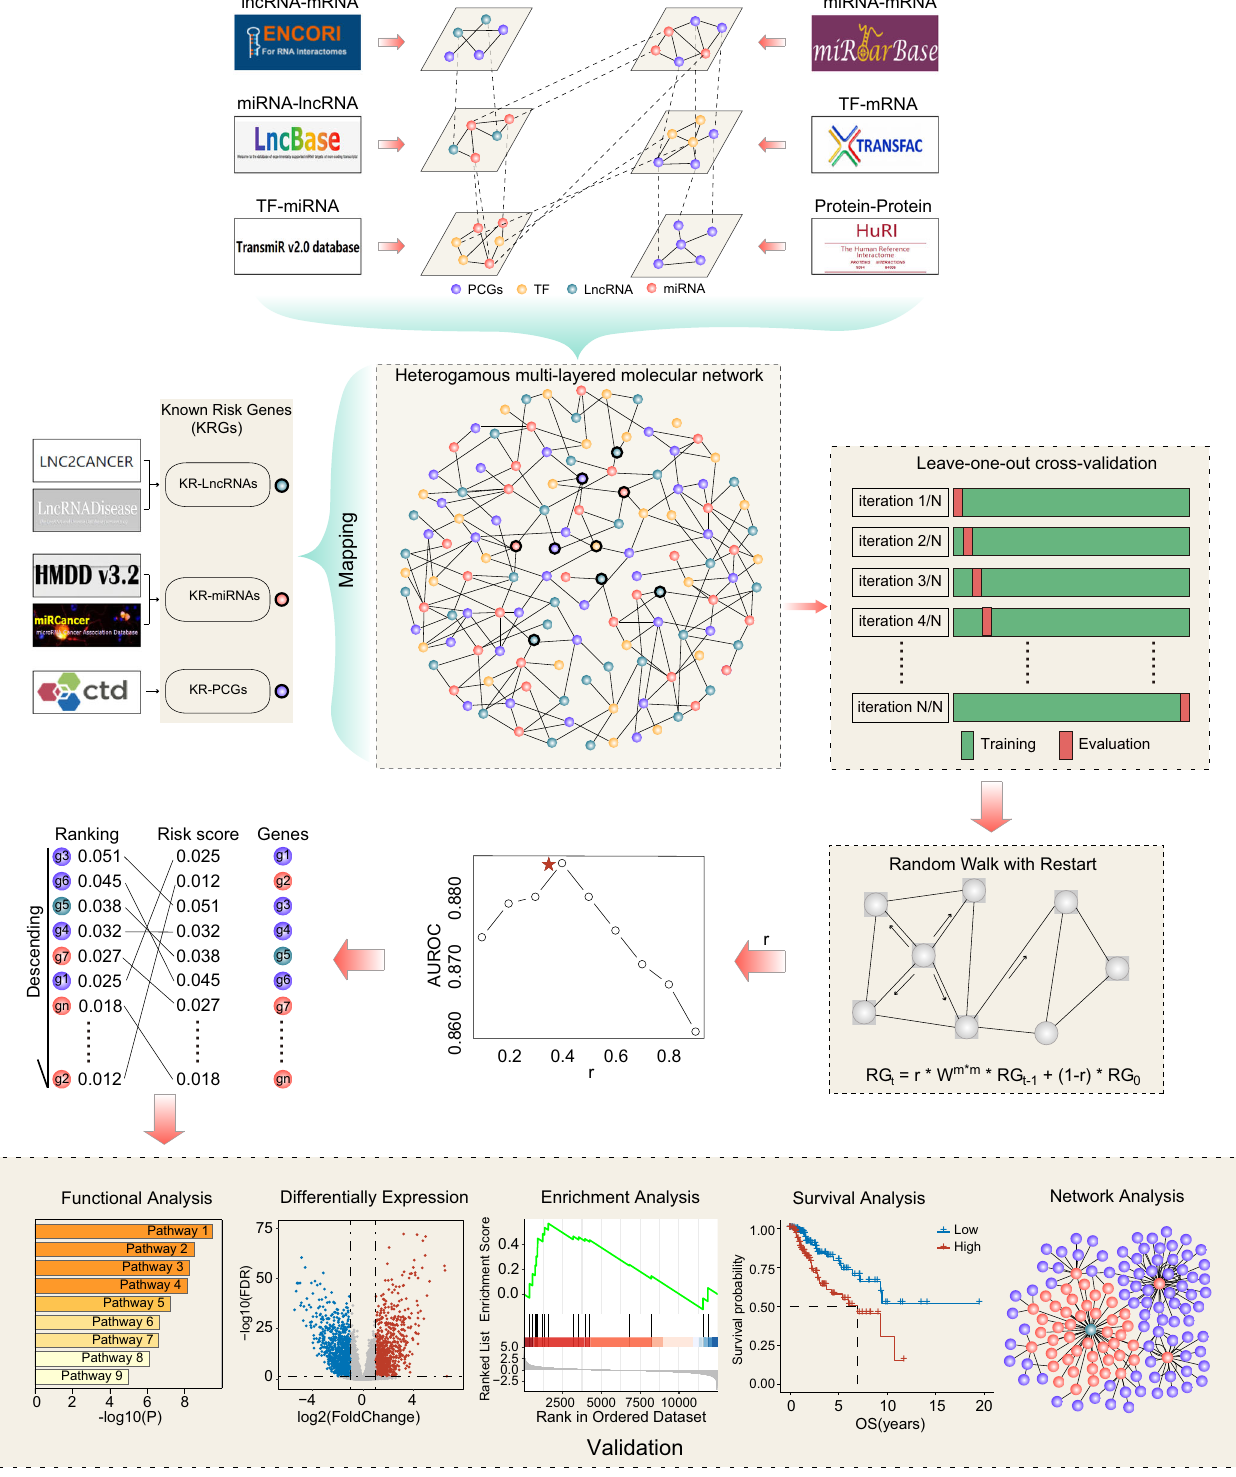
Fig. 1 Illustration of the overall framework of